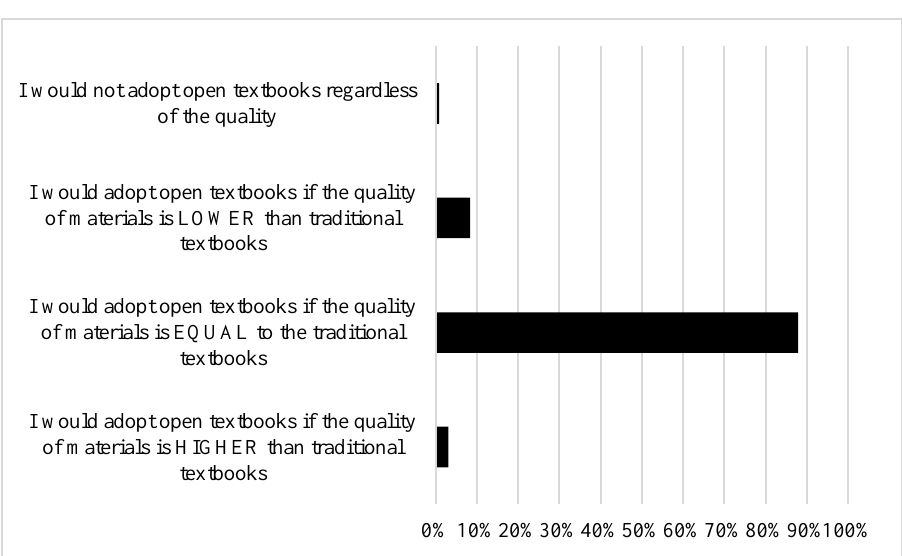
Figure 7 . Perception of quality and adoption